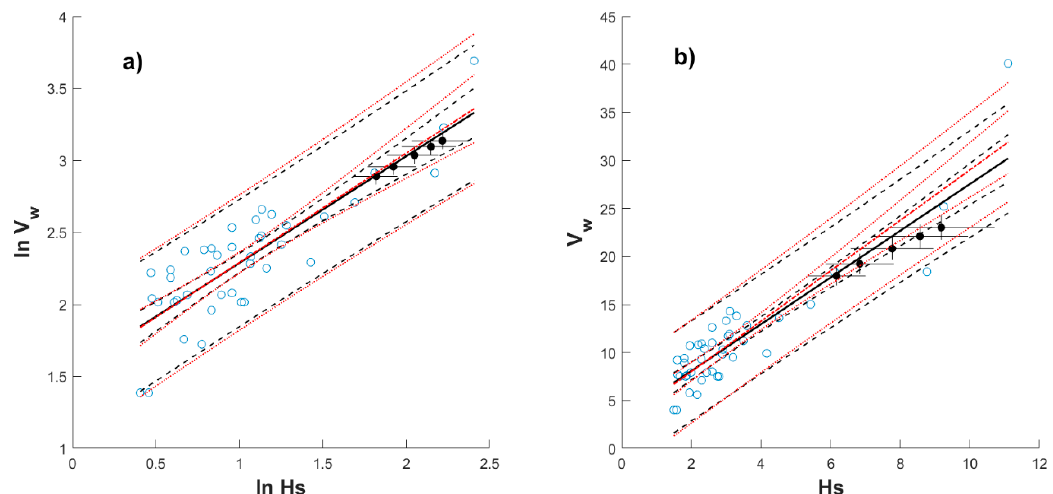
Figure A6. Regression lines and confidence intervals including (solid and dashed lines, respectively) and excluding (dashed–dotted and dotted lines, respectively) T -yr values for July; ( a ) and ( b ) for logarithmic space and linear space, respectively. Filled circles represent T -yr values with embedded perpendicular lines indicating confidence intervals from GEV models.